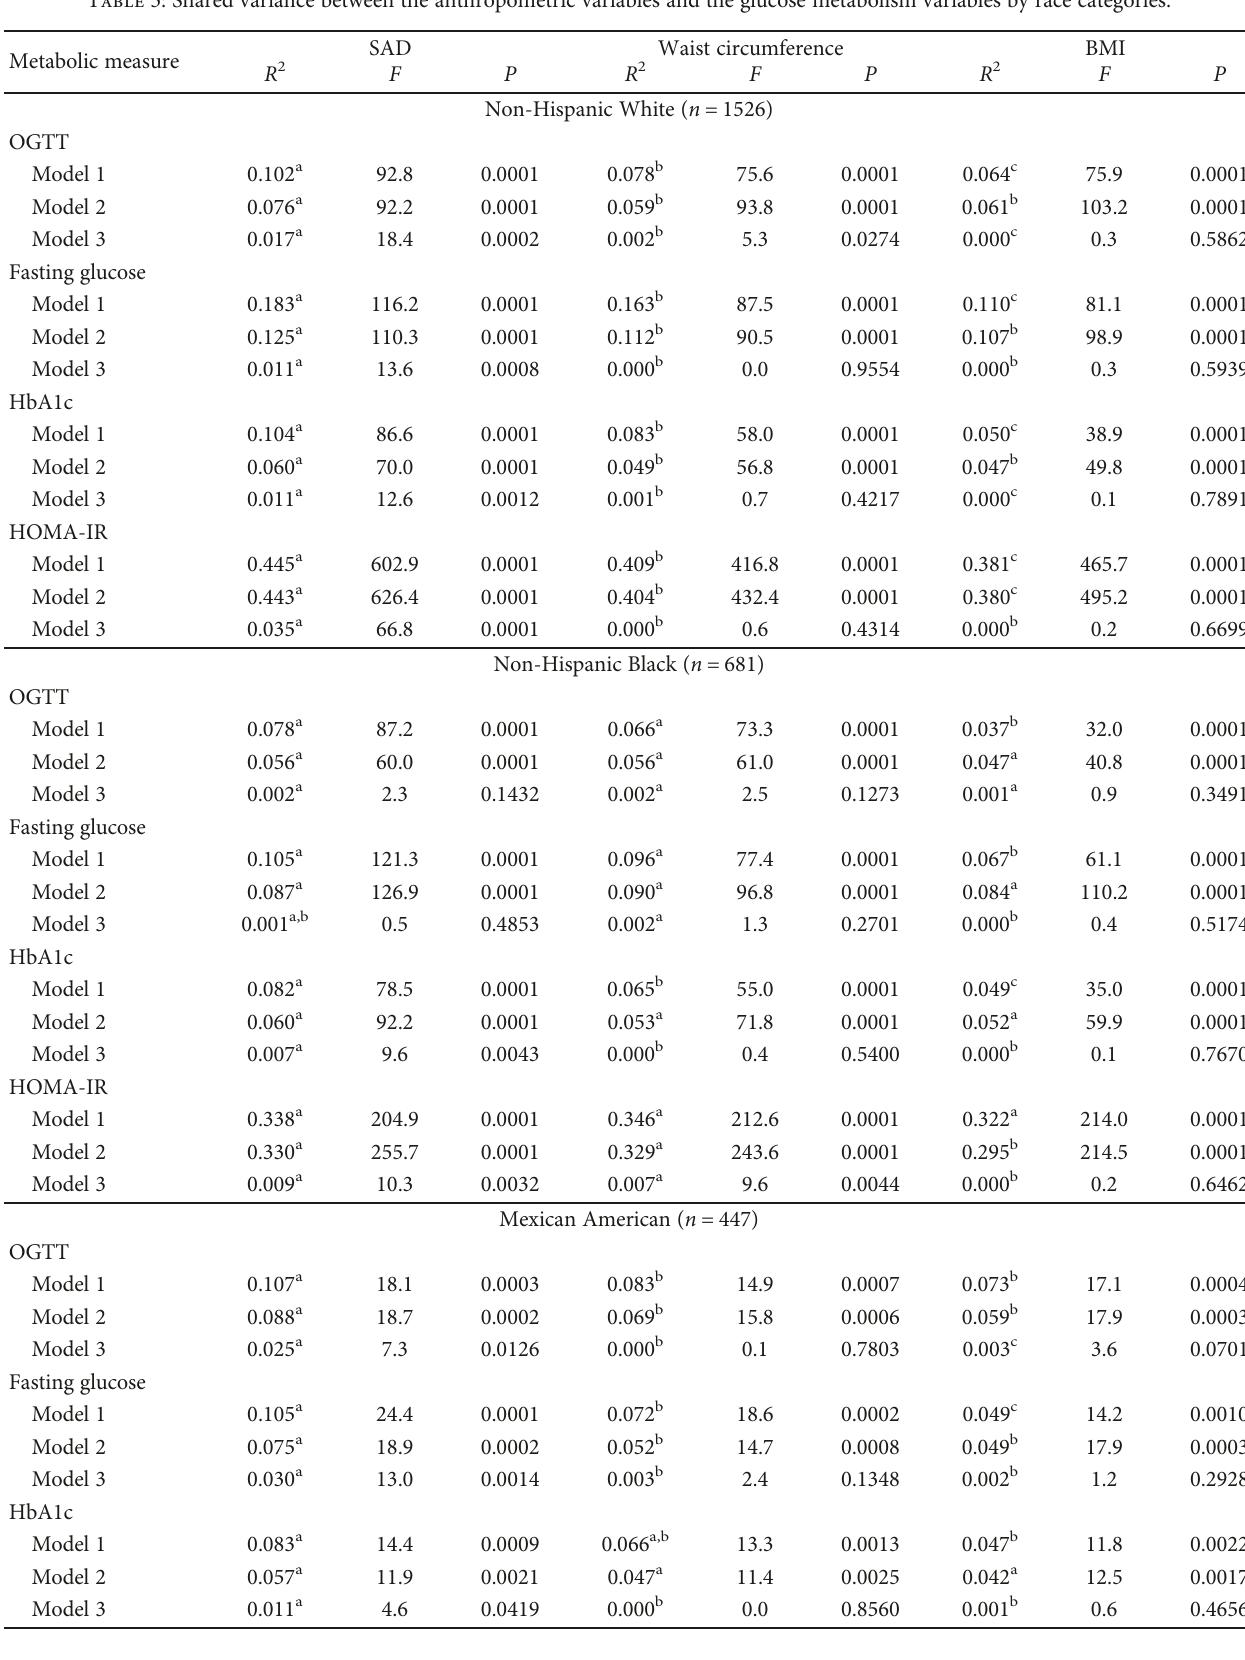
Table 5: Shared variance between the anthropometric variables and the glucose metabolism variables by race categories. Metabolic